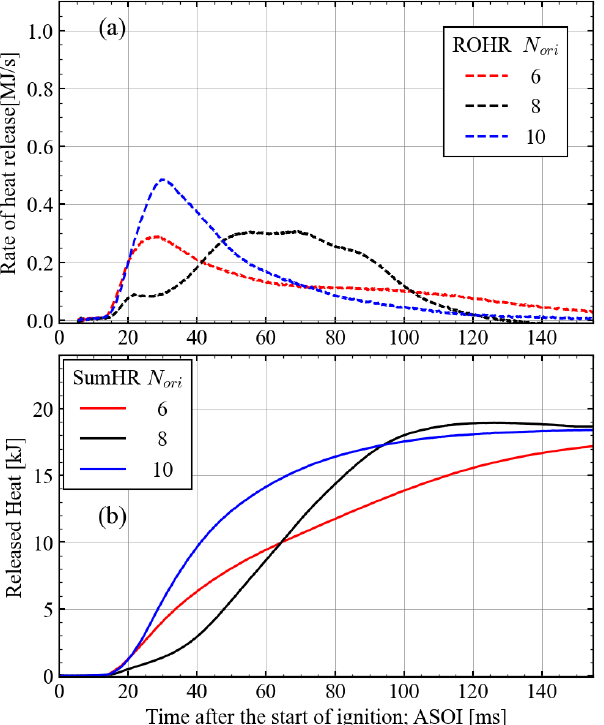
Fig. 13. Time history of (a) ROHR, and (b) of the different number of orifices (N ori = 6, 8,10) under “combustible” conditions